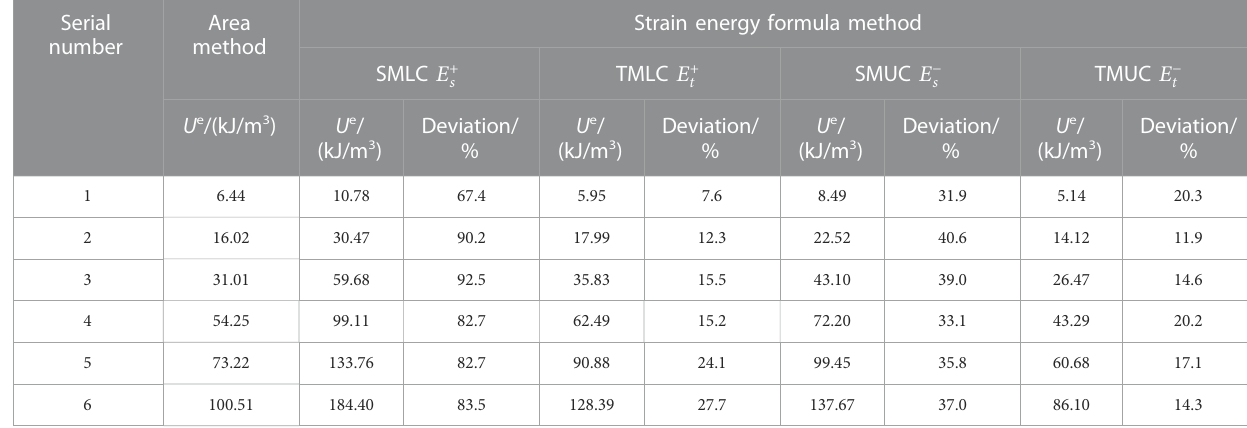
TABLE 1 Results of elastic strain energy calculated by different elastic modulus ( σ 3 = 0 MPa). Serial number